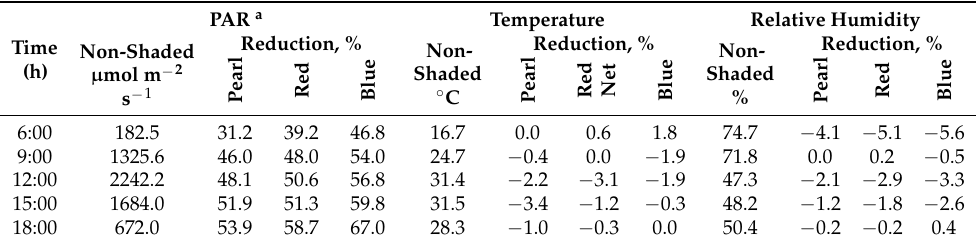
Antimicrobial activity of sweet basil oil was tested against nine microorganisms,